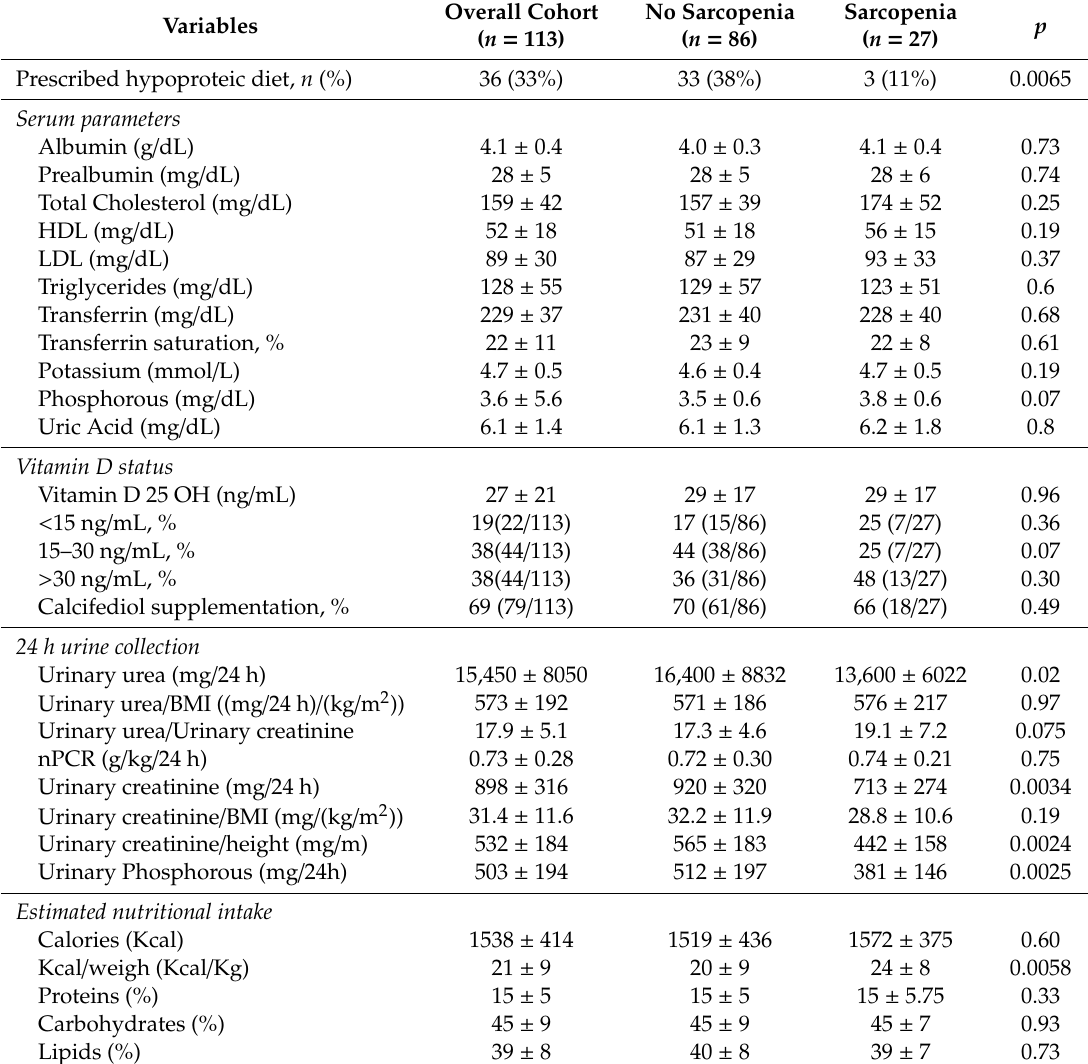
Table 2. Biochemical nutritional parameters and estimated nutritional